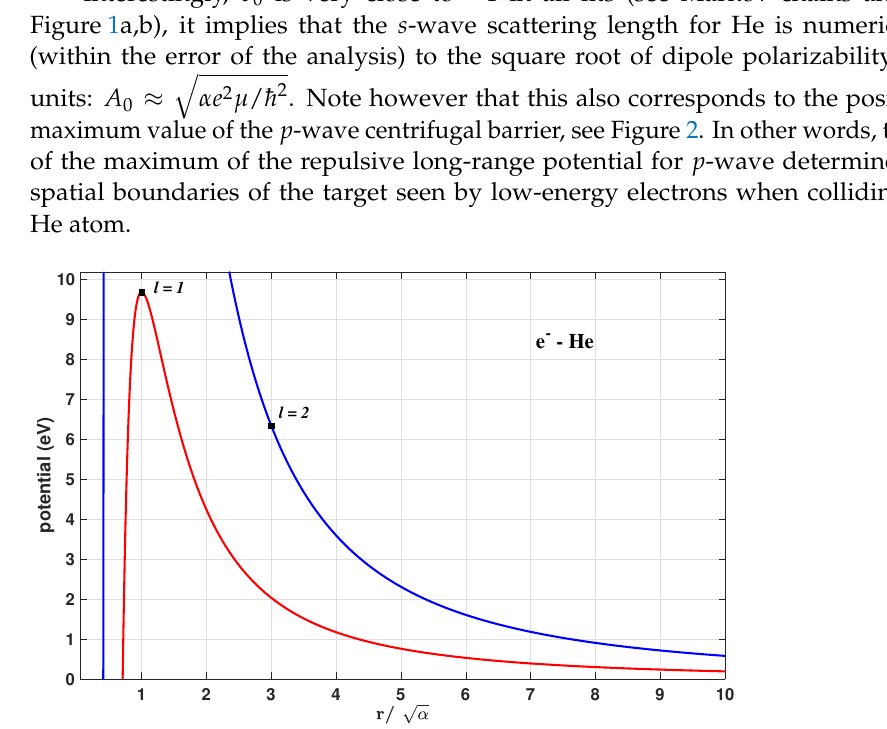
Figure 2. The positive (repulsive) part of the long-range electron − helium effective potentials for the p and d partial waves. The distance between interacting elements is scaled by the square root of dipole polarizability (in atomic units).